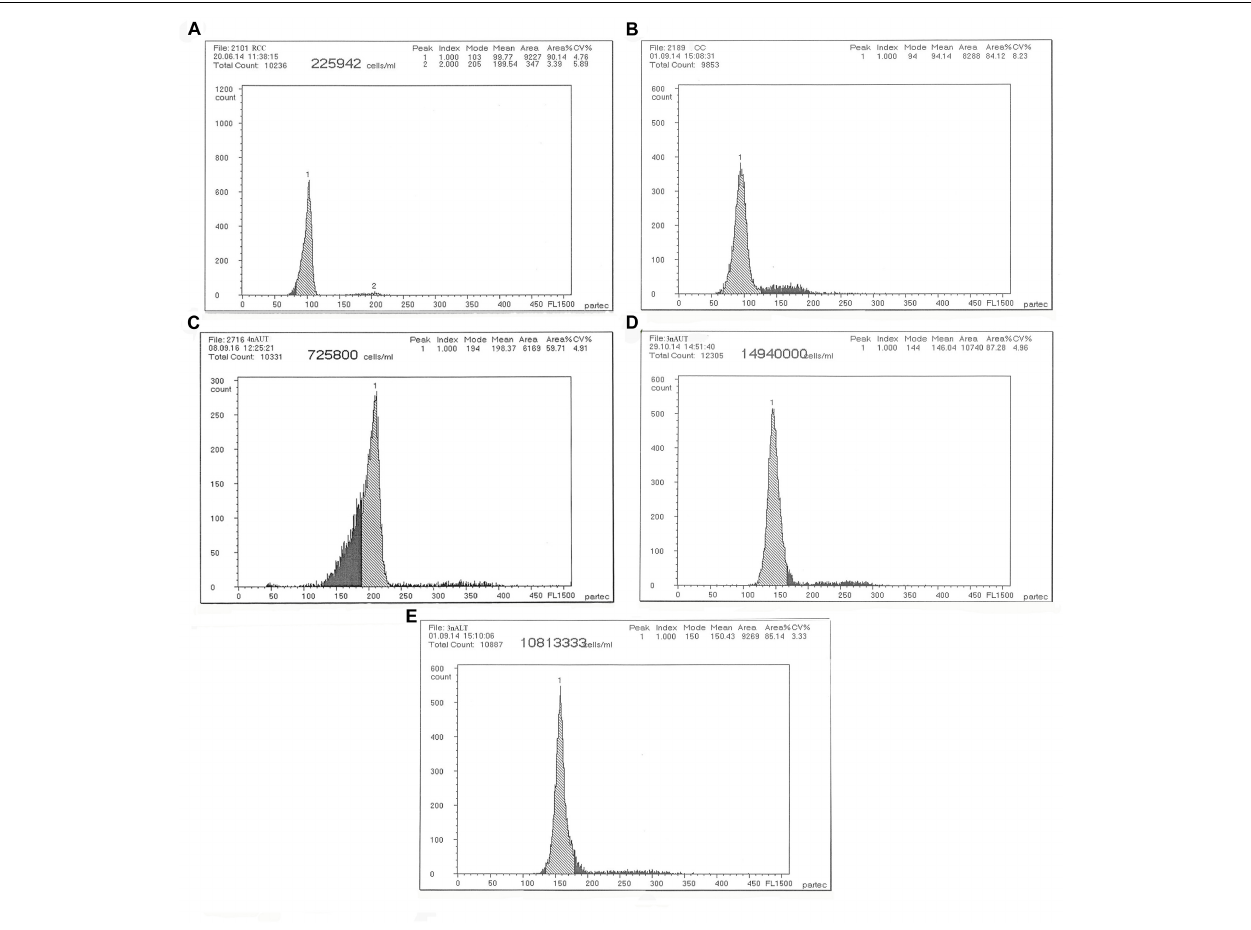
FIGURE 2 | Cytometric histograms of DNA fluorescence for RCC, CC, 4nAUT, 3nAUT, and 3nALT. (A) The mean DNA content of RCC (peak 1: 99.77). (B) The mean DNA content of CC (peak 1: 94.14). (C) The mean DNA content of 4nAUT (peak 1: 198.37). (D) The mean DNA content of 3nAUT (peak 1: 146.04). (E) The mean DNA content of 3nALT (peak 1: